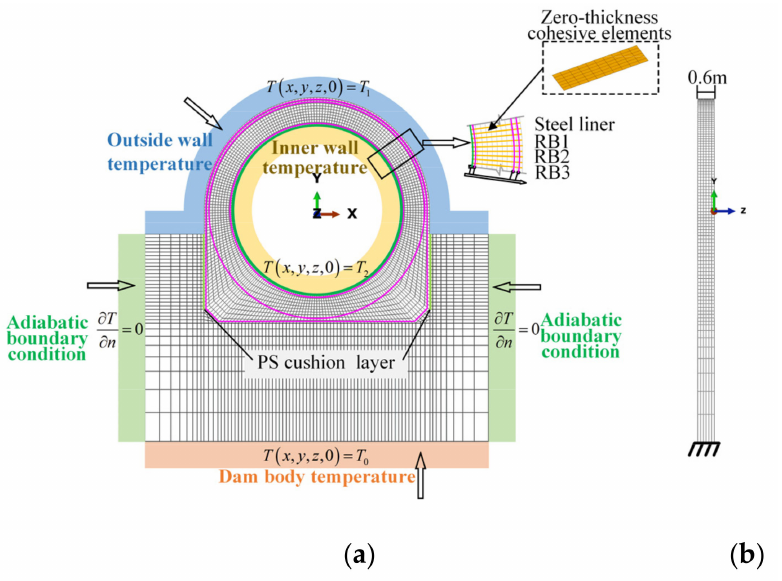
Figure 11. The 3D finite element model of the penstock: ( a ) front section and ( b ) side